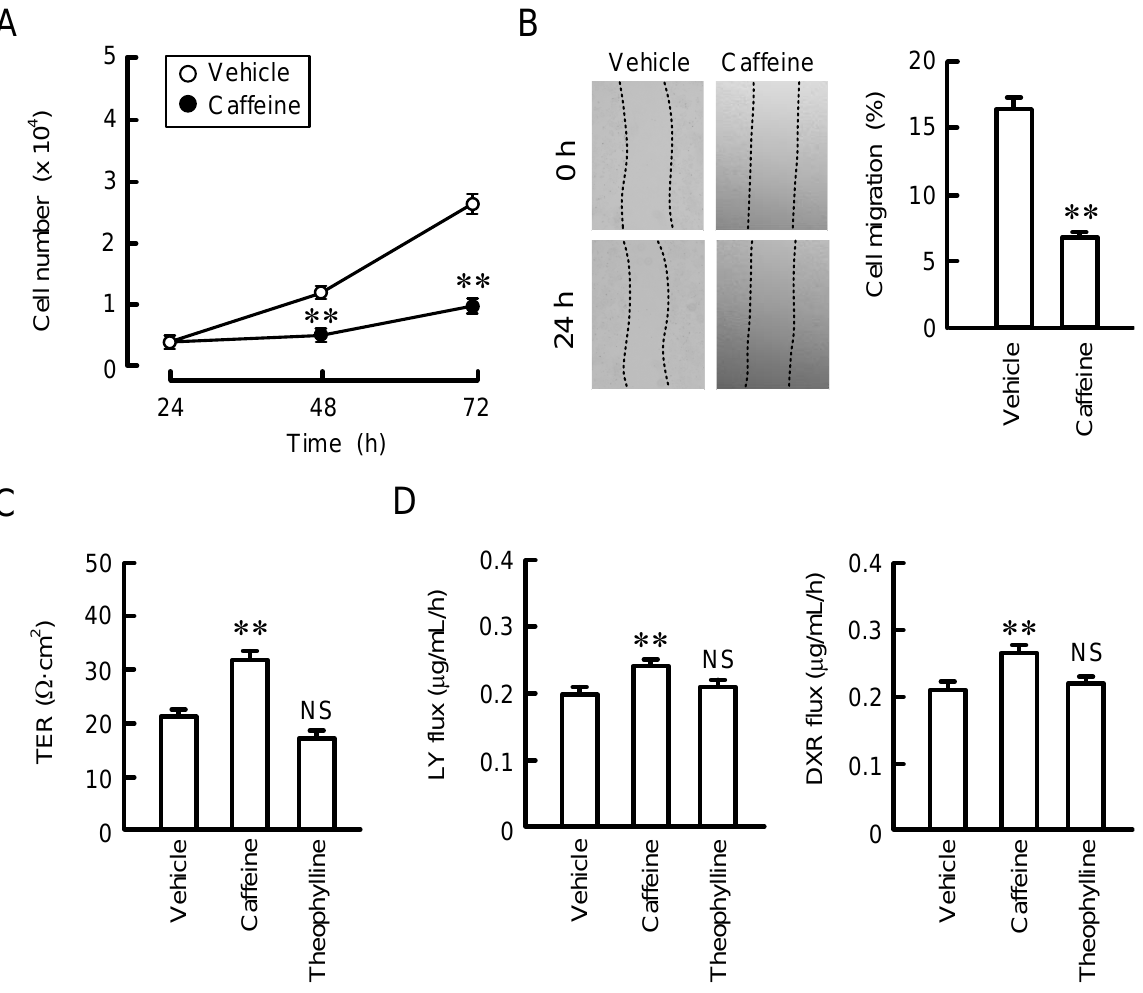
Figure 6. Effects of caffeine and theophylline on cell proliferation, migration, and paracellular barrier function. ( A , B ) Cells cultured on 6 cm dishes were incubated in the absence (vehicle) or presence of 200 µ M caffeine. In the proliferation assay, cell images were obtained at 24, 48, and 72 h, and the number was calculated. In the wound-healing assay, cell images were obtained at 0 and 24 h after wound creation, and the remaining wound area was calculated. ( C , D ) Cells cultured on Transwell inserts were incubated in the absence (vehicle) or presence of 200 µ M caffeine or theophylline for 24 h. TER was measured using a volt ohm meter. The fluxes of LY and DXR were measured using a microplate reader. Then, the solution in the basal compartment was collected, followed by a measurement of the fluorescence intensity. n = 4. ** p < 0.01 and NS p > 0.05 compared with vehicle.